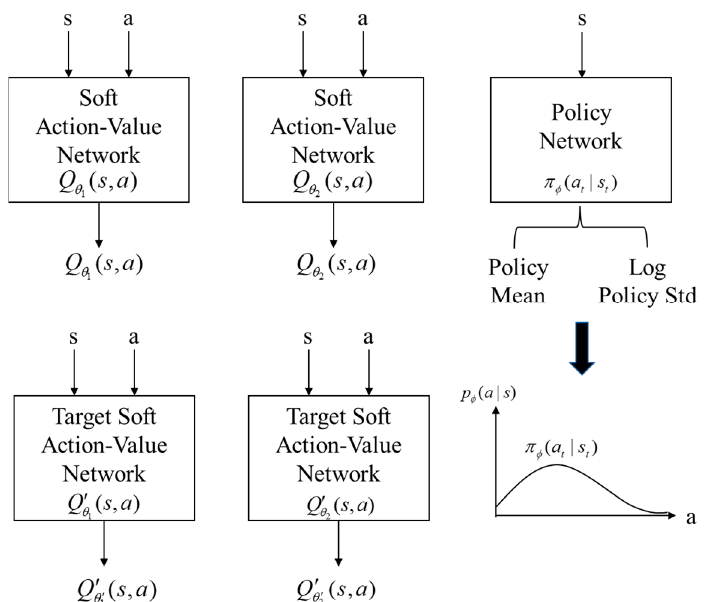
Figure 3. Neural network architecture of SAC.